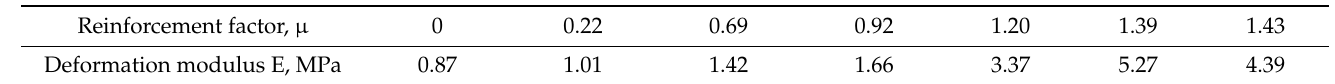
Figure 8. The laboratory PLT elastic deformation for various reinforcement areas before and after the reinforcement. Reference samples without reinforcement correspond to “ test wo reinf µ = 0 ”. The legend specifies the number of reinforcing elements: 1, 3, 9 or 27 reinf. Elements with 40 cm extended lengths at the edges (sample No6) or at the middle (sample No 7) are specified as “ edge 40 cm ” or “ mid40 cm ” accordingly. Table 3. Summary of the deformation modulus E from test results at a loading pressure of 100 – 200 kPa.